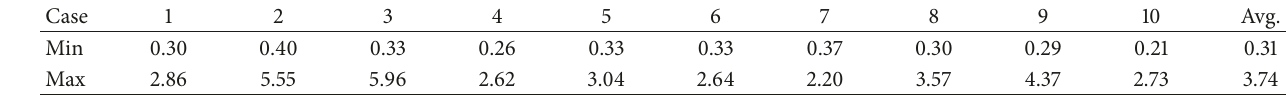
Table 3: The Min and Max Jacobians according to MI-CC-SyN